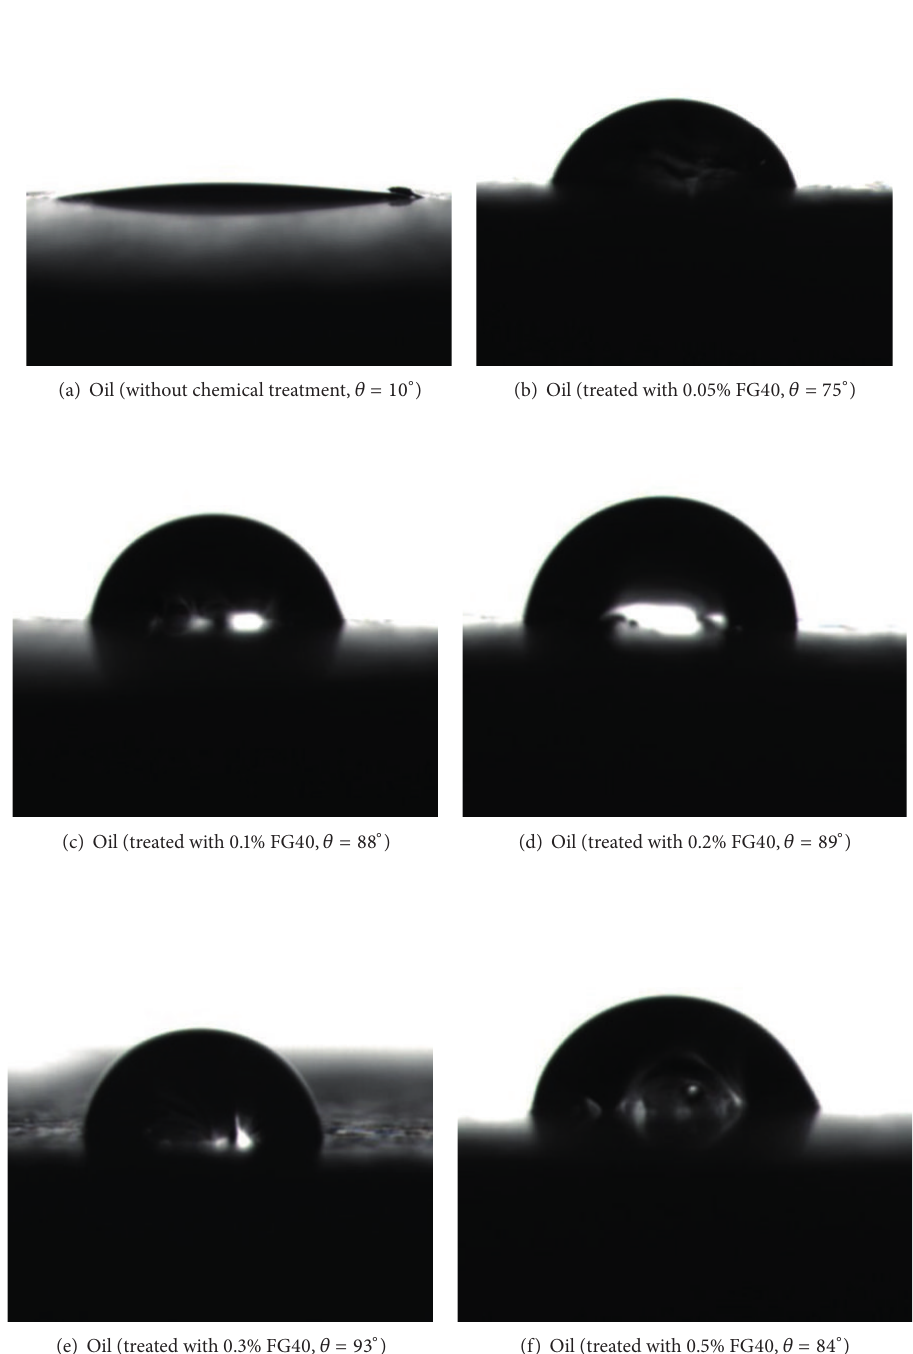
Figure 4: Oil droplets on the surface of the sandstone cores before and after treatment with